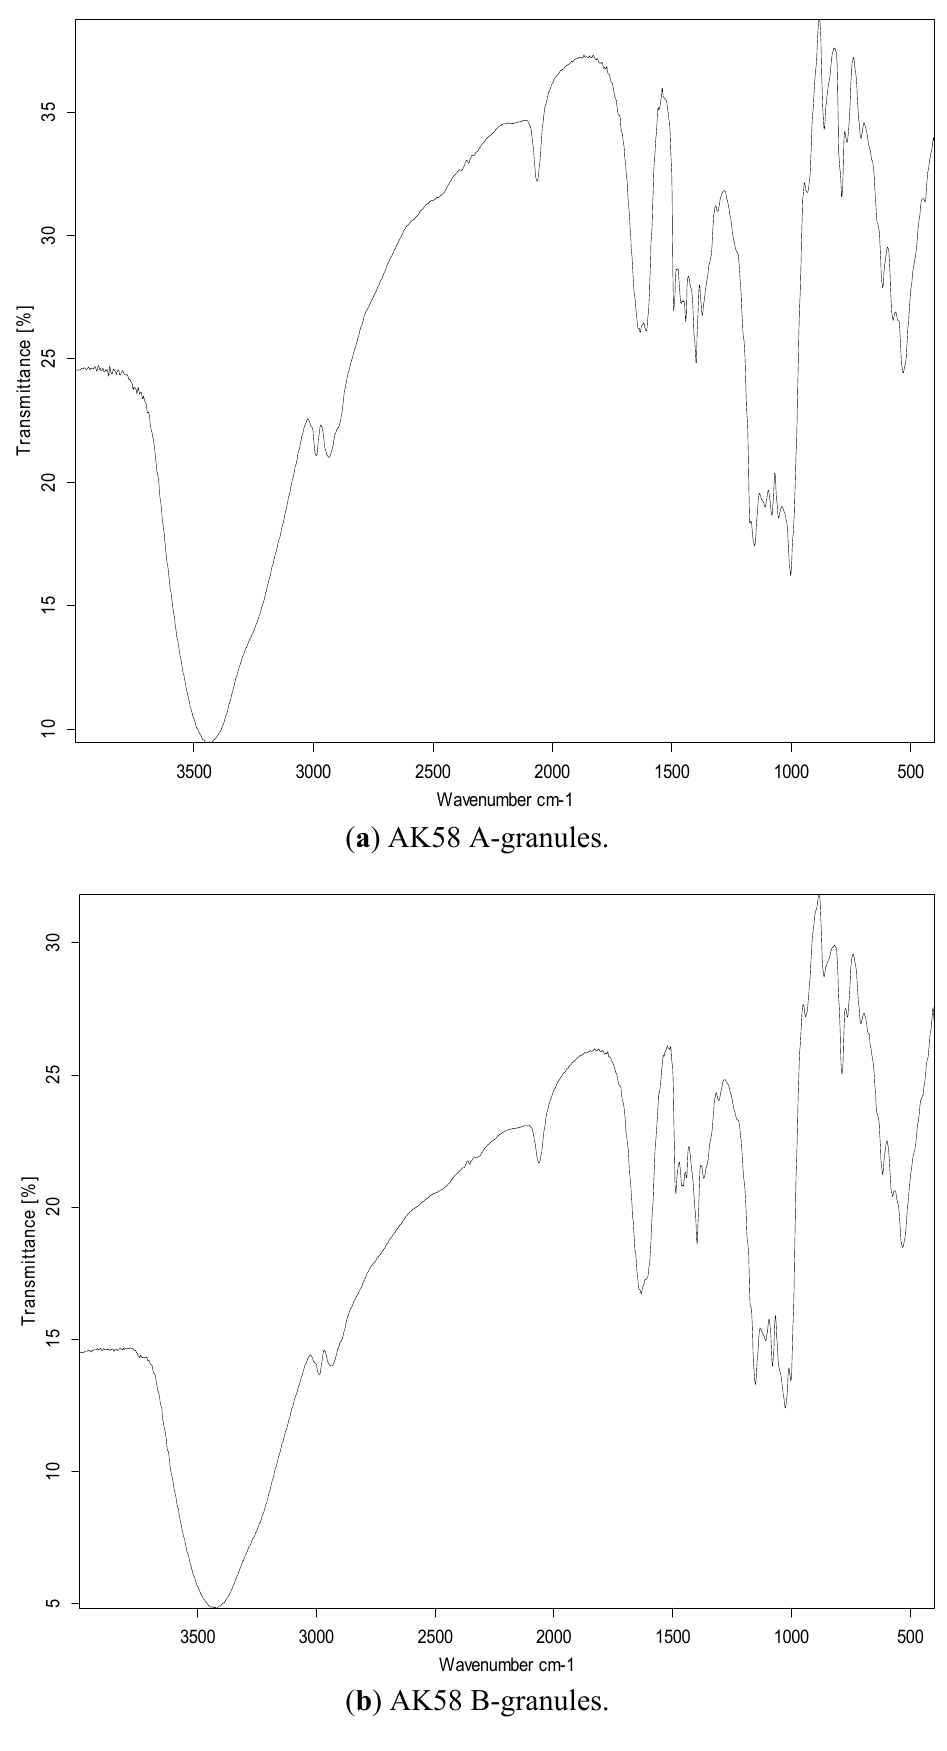
Figure 2. Infrared spectra of unfractionated starch and isolated A- and